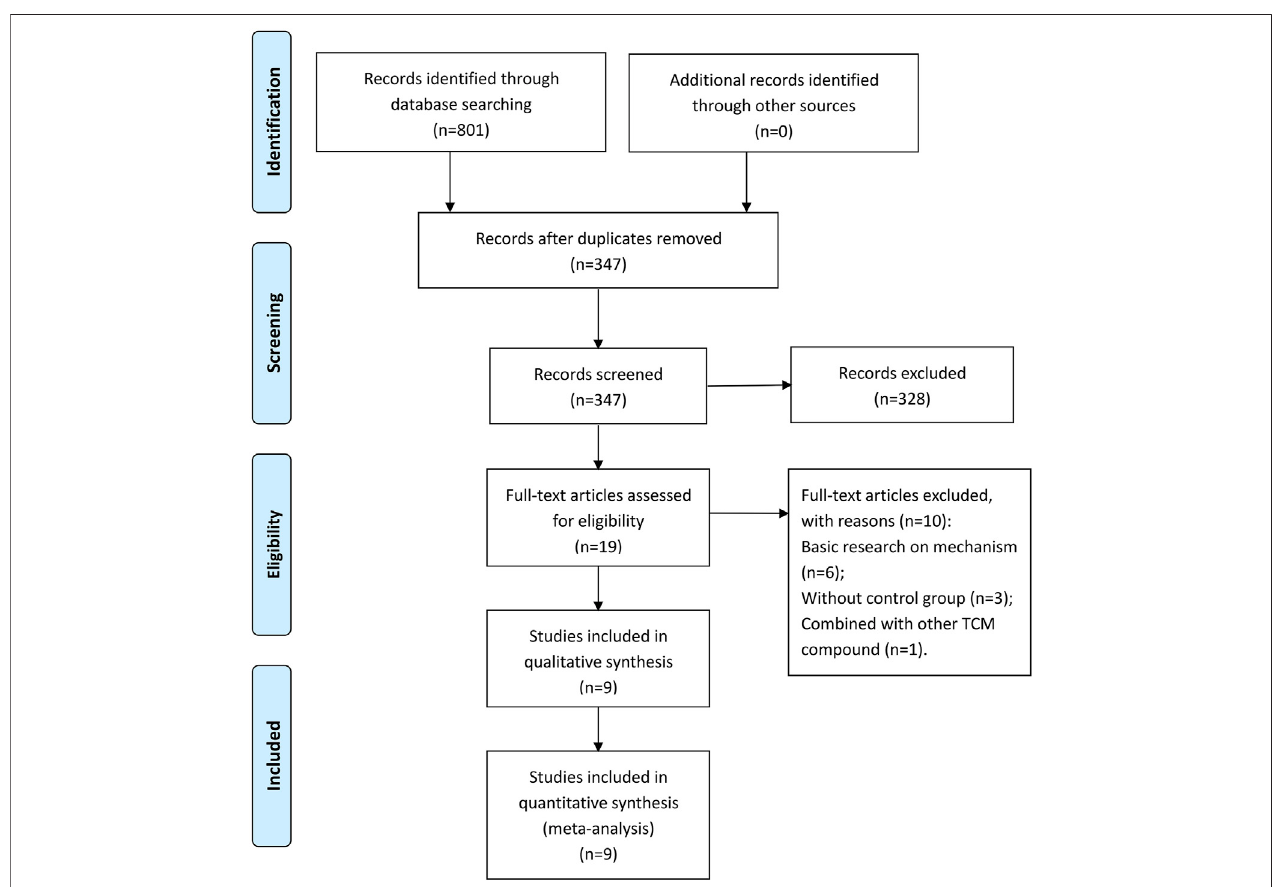
FIGURE 1 | PRISMA fl ow diagram of screening